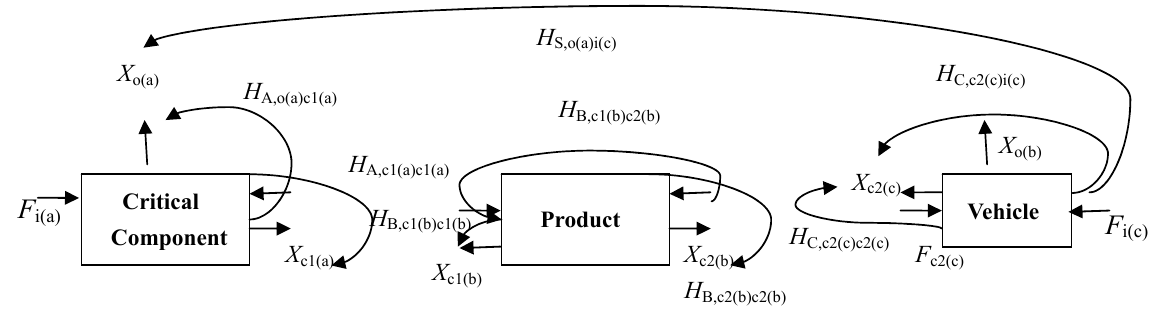
Fig. 9. Signi fi cation of the FRFs of the